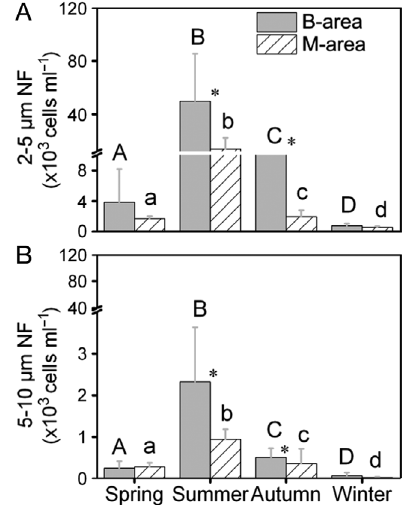
Fig. 5. Mean (+SD) abundance of (A) 2−5 µm nanoflagel- lates (NF) and (B) 5−10 µm NF in the B-area and M-area (see Fig. 1). *Significant difference (p < 0.05, t -test) between the 2 areas in the same season. Different uppercase and lower- case letters indicate significant (p < 0.05) differences among 4 seasons for B-area and M-area,